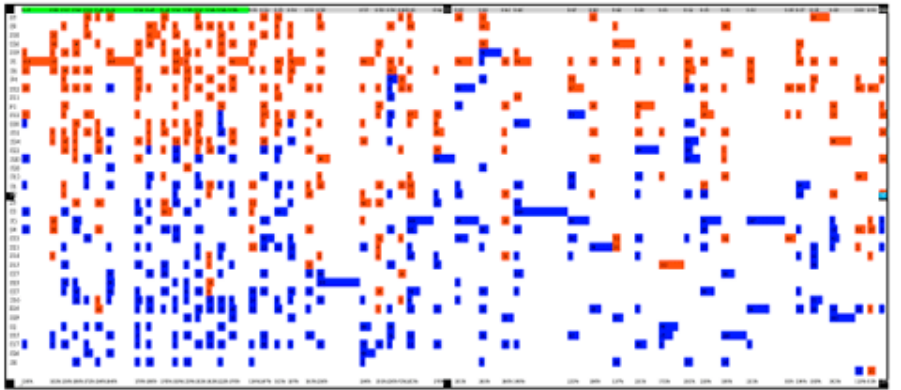
Figure 4. Time-use in the online class. The green bar represents the activity period. After the activity period, there are 30 columns, one per minute. The red bars total 30 minutes of statements, while the blue bars total 46 minutes – for a total effective time of 76 minutes worth of statements in the non turn-taking environment. Each row represents a participant in the